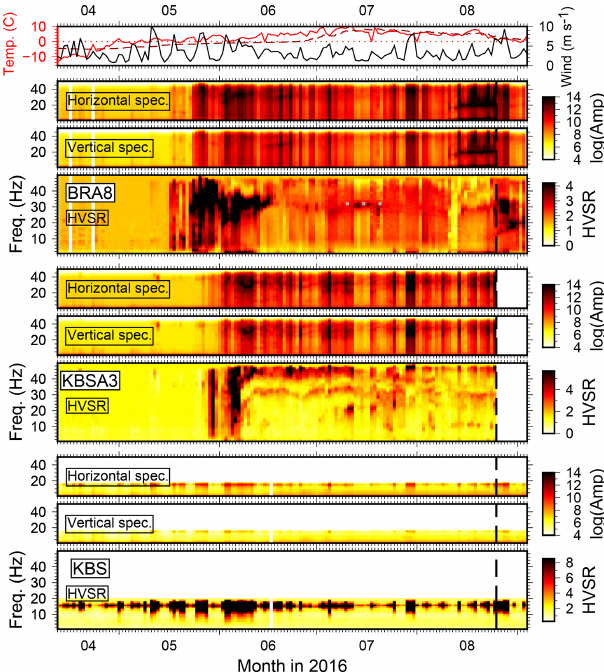
Figure A3. Same as Fig. 2 for three more